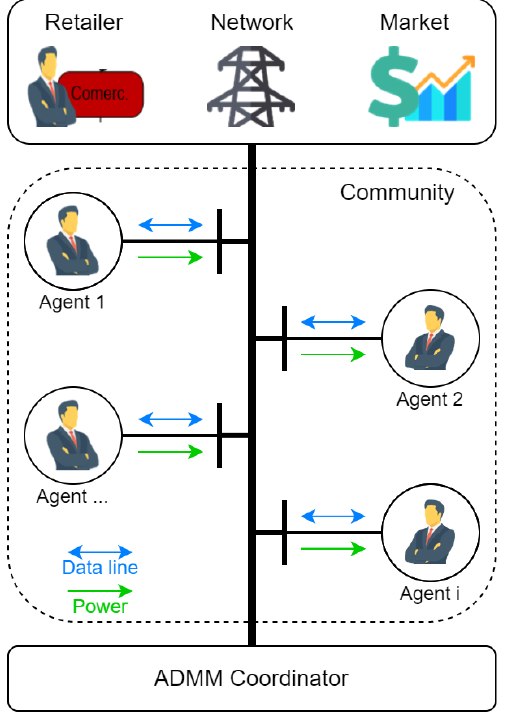
Figure 1. Decentralized community-based market